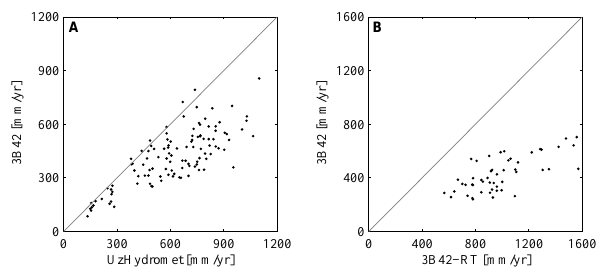
Fig. 4. Comparison of precipitation datasets. (A) Mean observed annual precipitation at 16 stations and corresponding pixel from 3B42 research product. (B) Mean catchment precipitation from real time and research 3B42 products. Fig. 5. 3B42 average monthly precipitation and ECMWF 10-day average temperatures against observed (UzHydromet) data at three locations (see Fig. 1 for